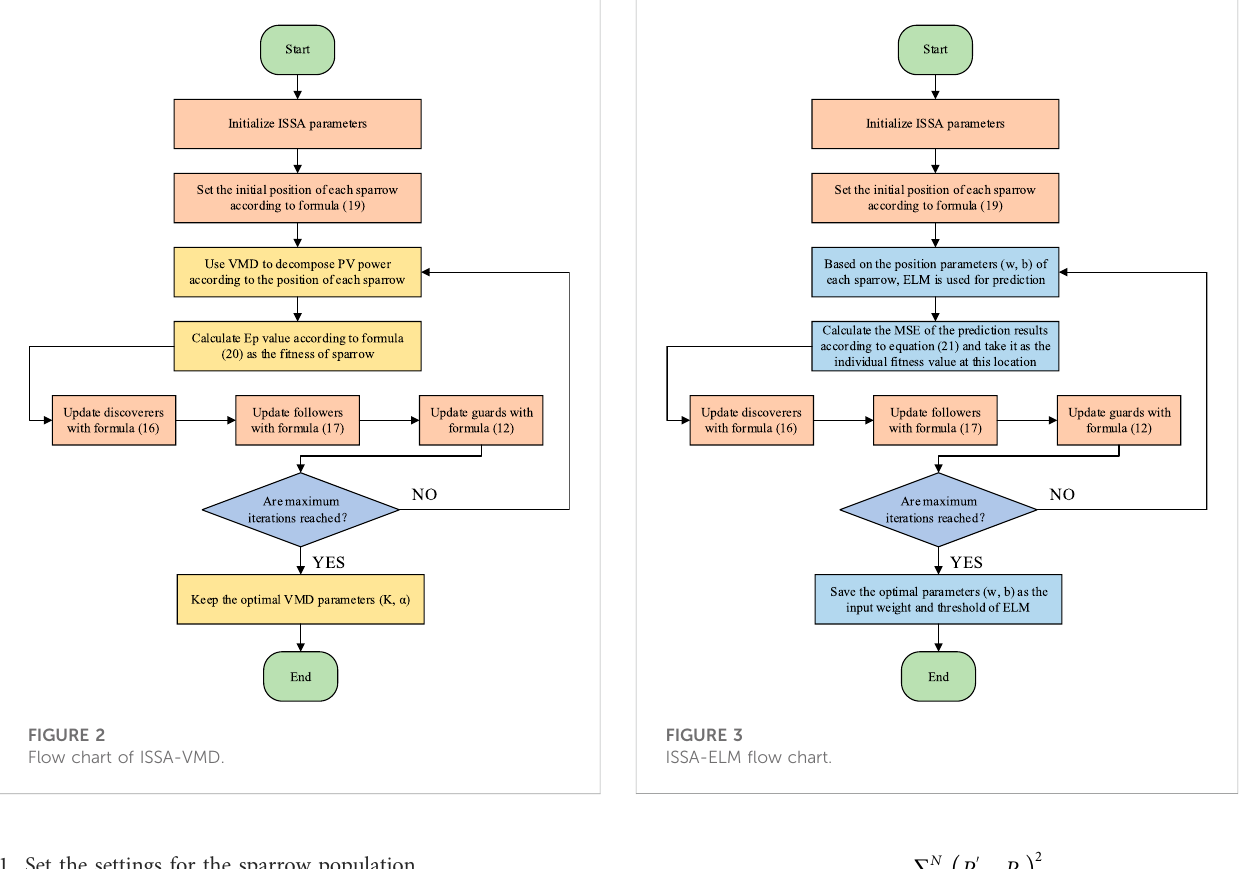
FIGURE 3 ISSA-ELM fl ow chart.